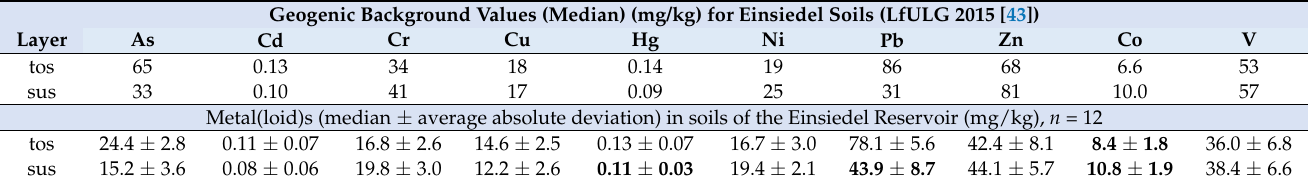
Table 3. Comparison between the metal(loid) background values for Saxon top- (tos) and subsoils (sus) on phyllite (land use: forestry) [43] and the measured metal(loid) concentrations of the soil samples within the Einsiedel Reservoir catchment. Values in bold exceeded the background